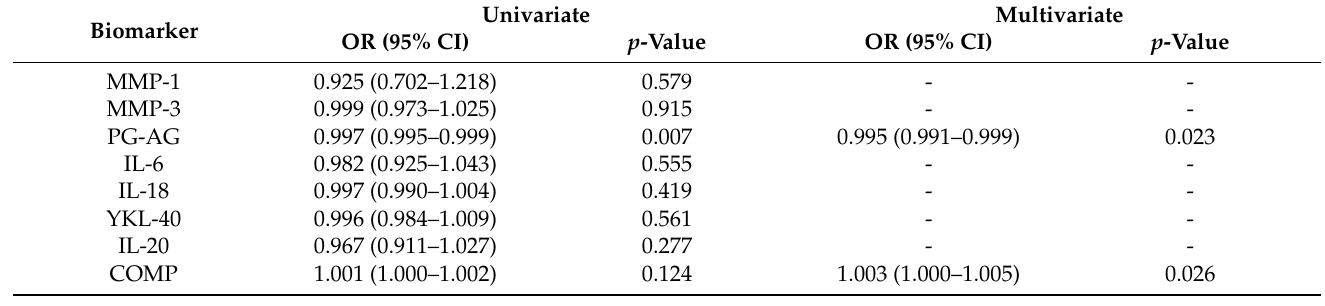
Table 2. Results of univariate and multivariate logistic regression analyses comparing serum levels of OA to PsA.